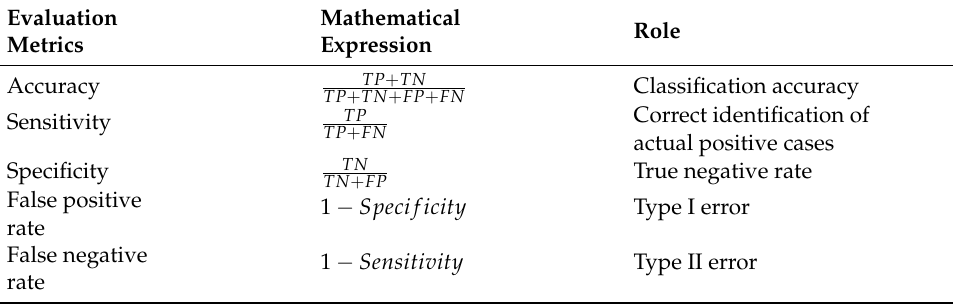
Table 4. The evaluation metrics used in this research.